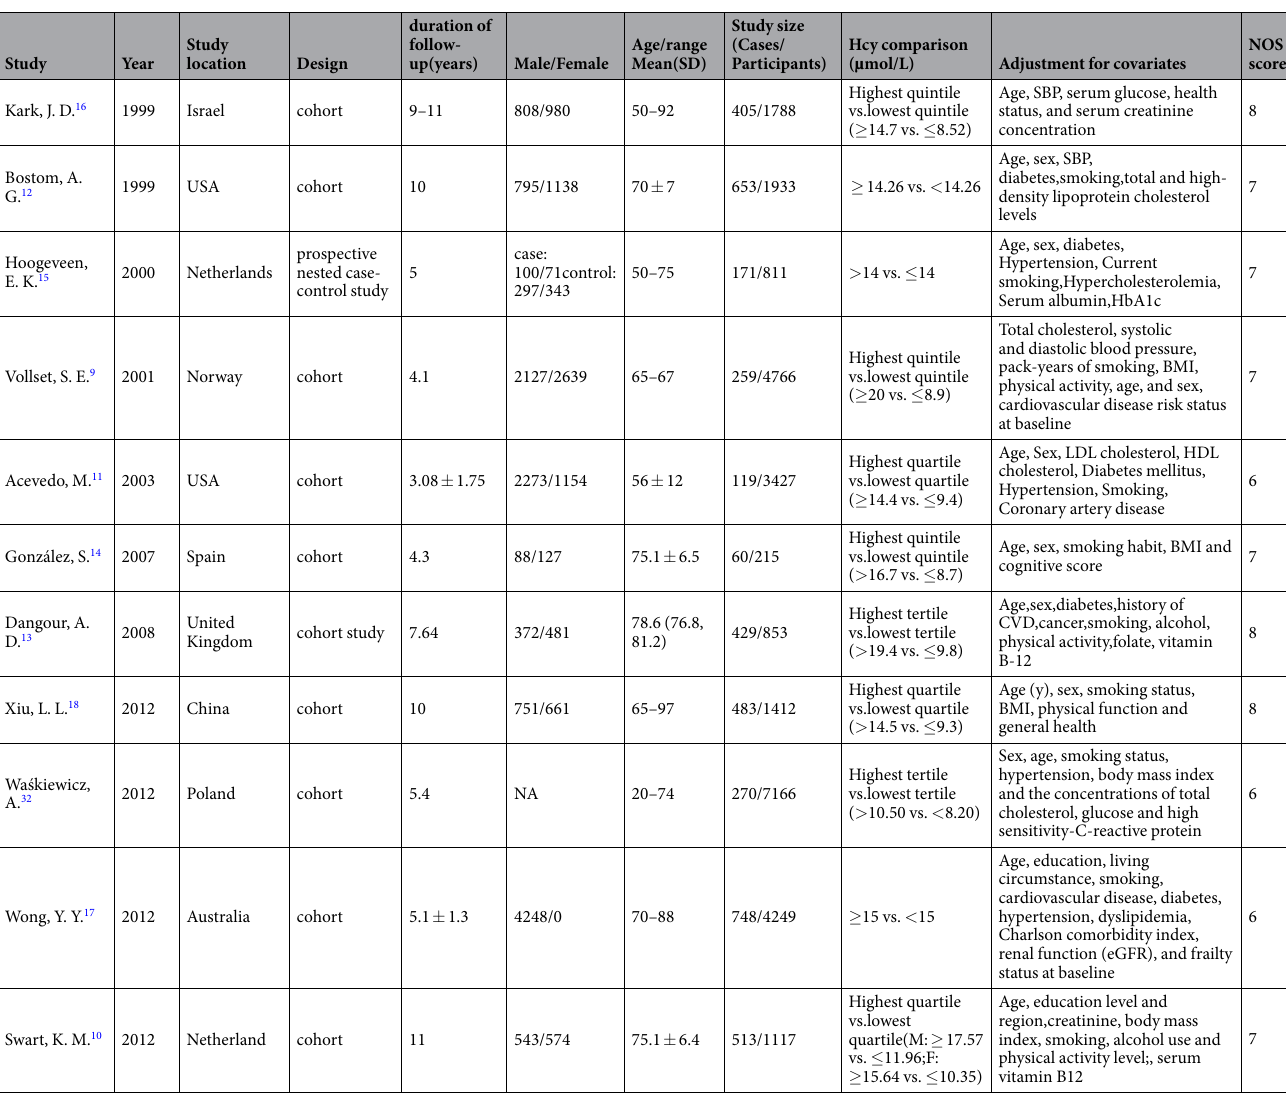
Table 1. General characteristics of the included